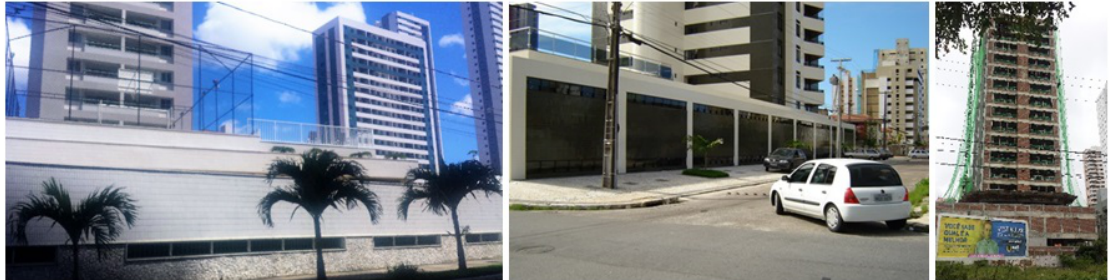
Figure 9. Frontages of high-rise residential buildings in Manaíra; walls of semi-underground and ground floor garages.